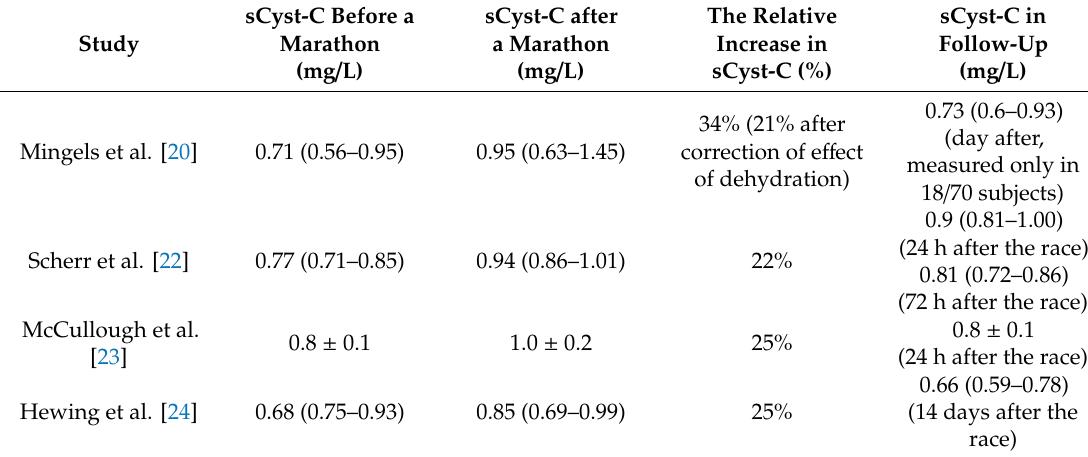
Table 2. Changes in sCyst-C level after a